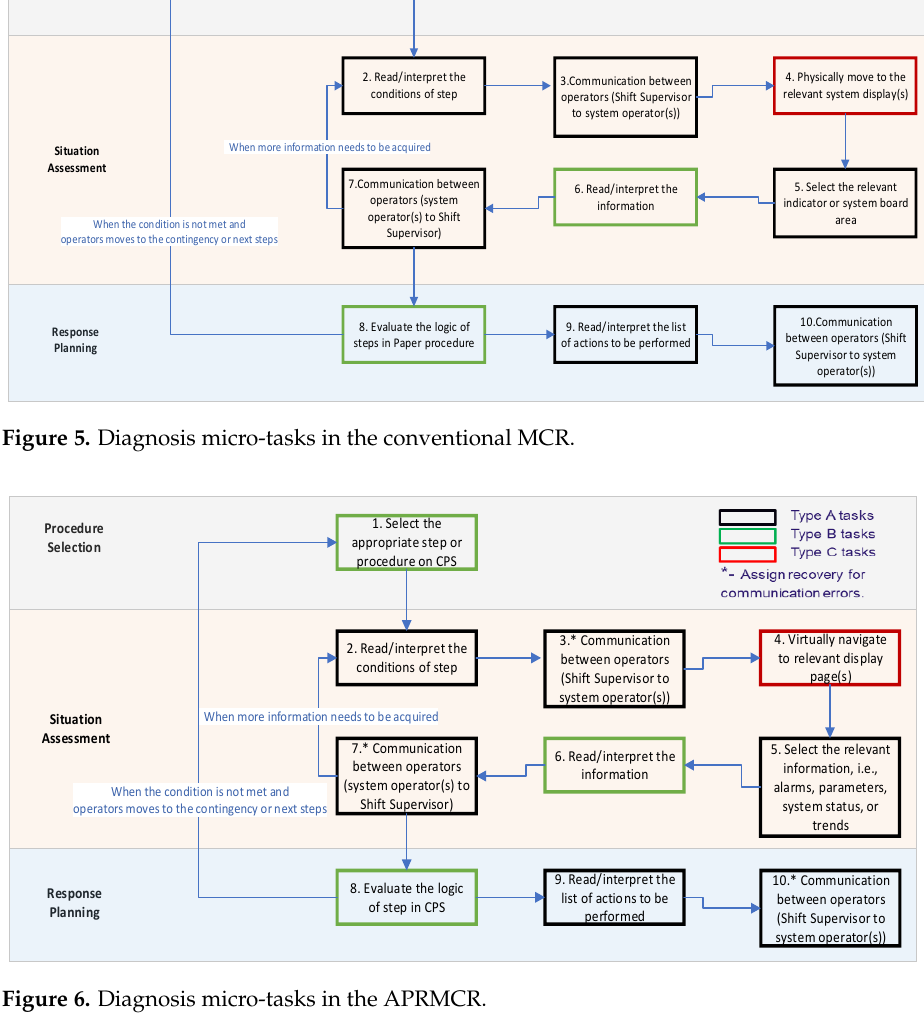
Table 1. Comparison of micro-tasks of conventional MCRs versus APRMCRs.